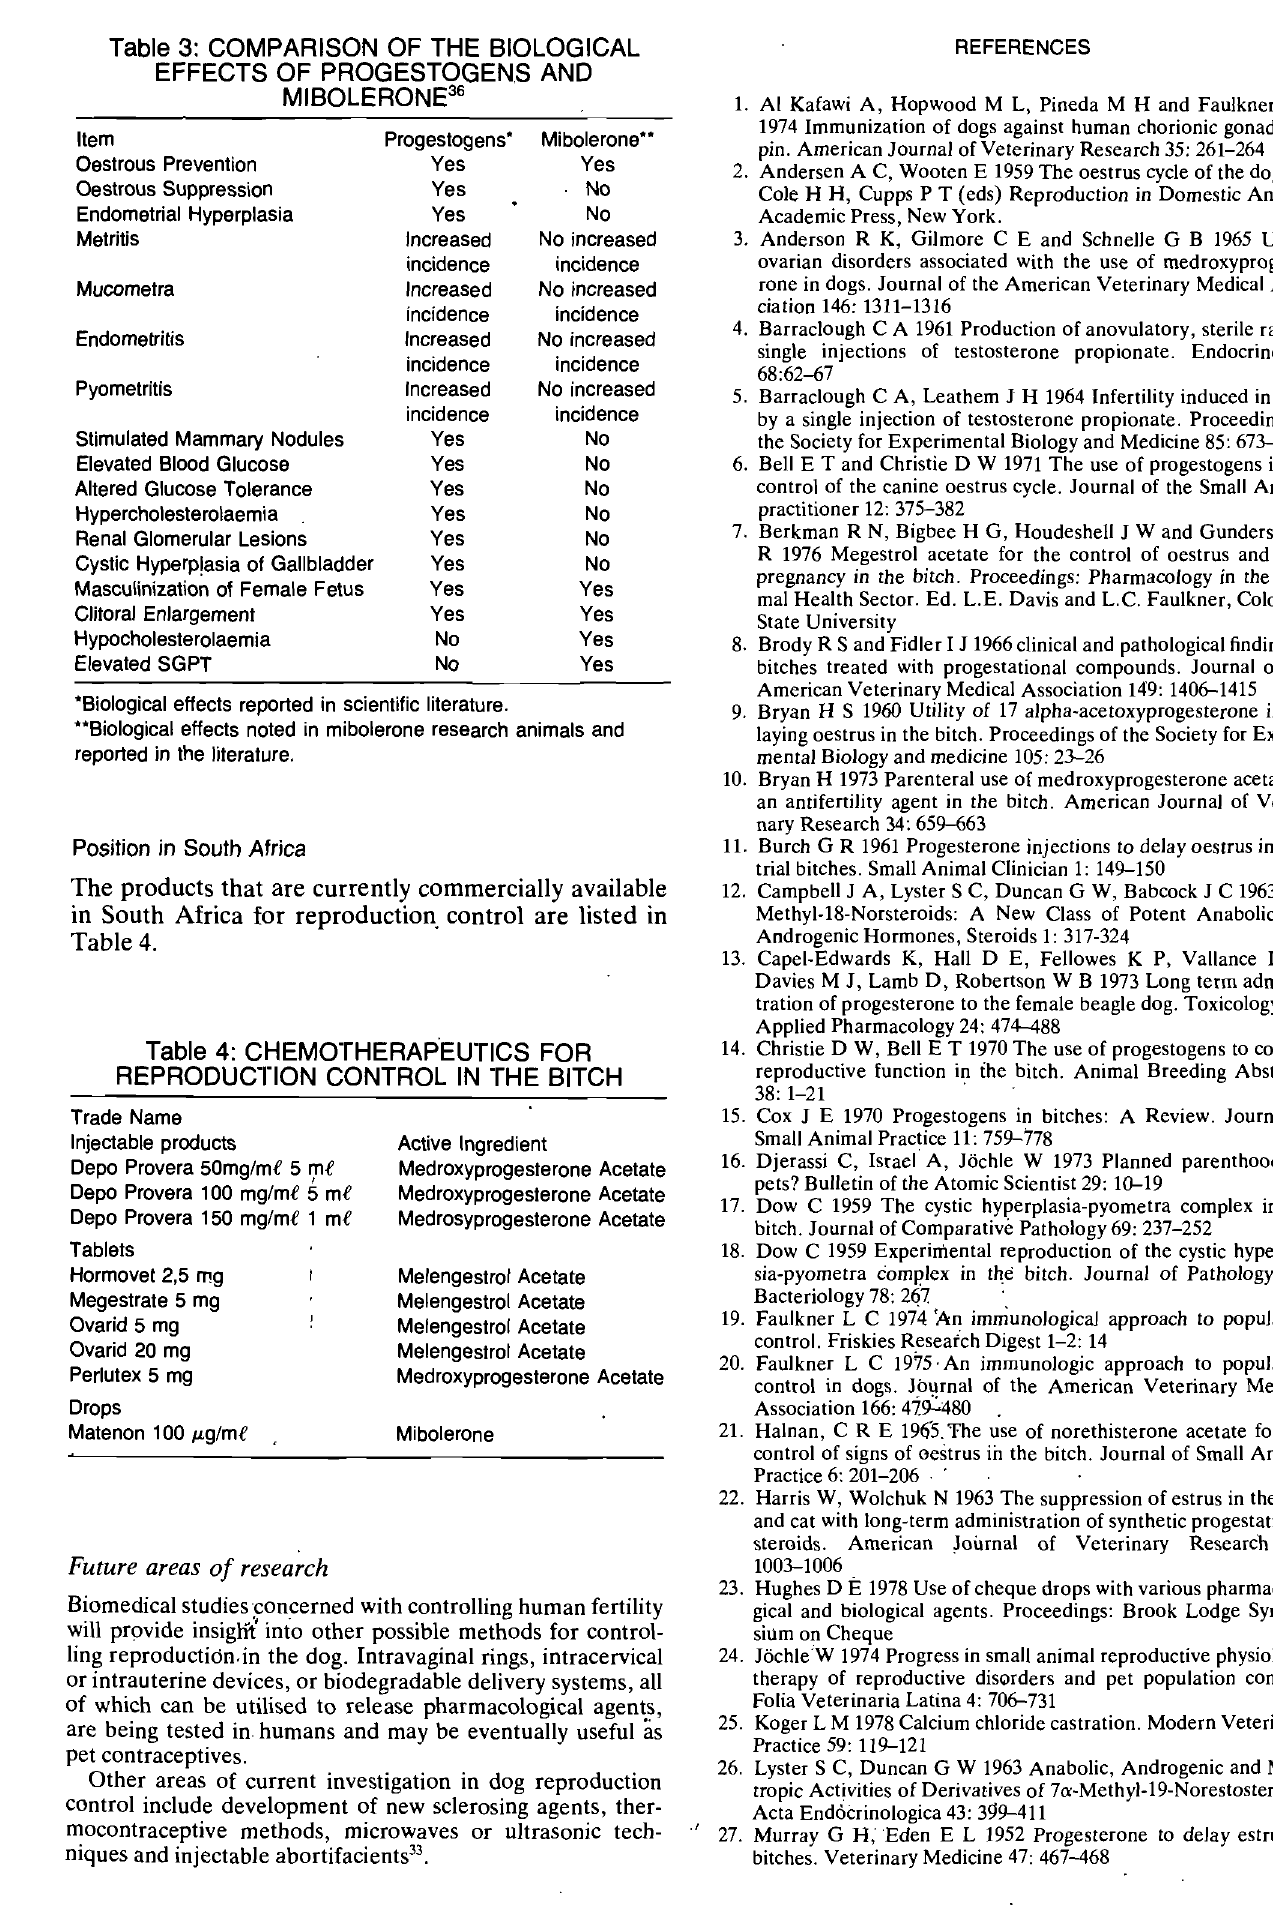
Table 3: COMPARISON OF THE BIOLOGICAL EFFECTS OF PROGESTOGENS AND